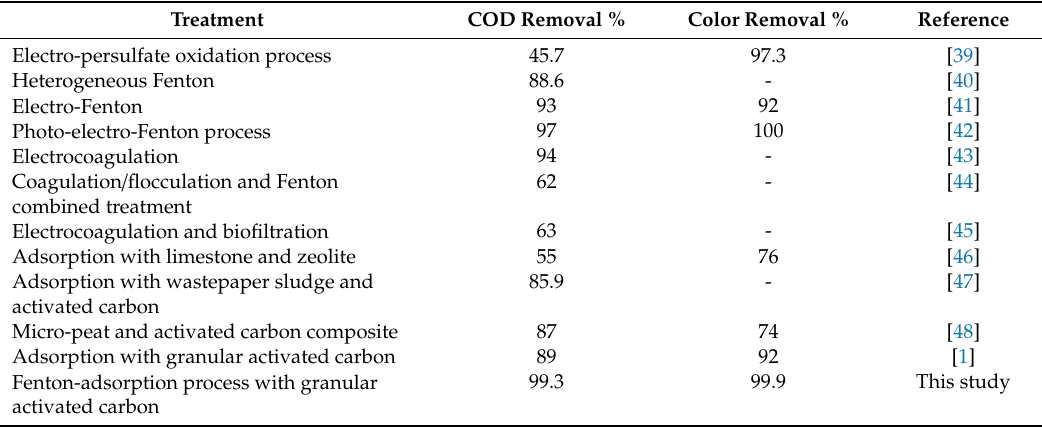
Table 6. Comparison of the COD and color removal e ffi ciencies with di ff erent treatments applied to landfill